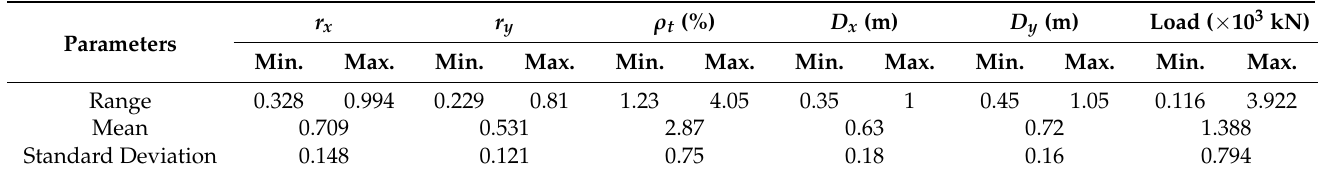
Table 1. Statistical parameters of the total data